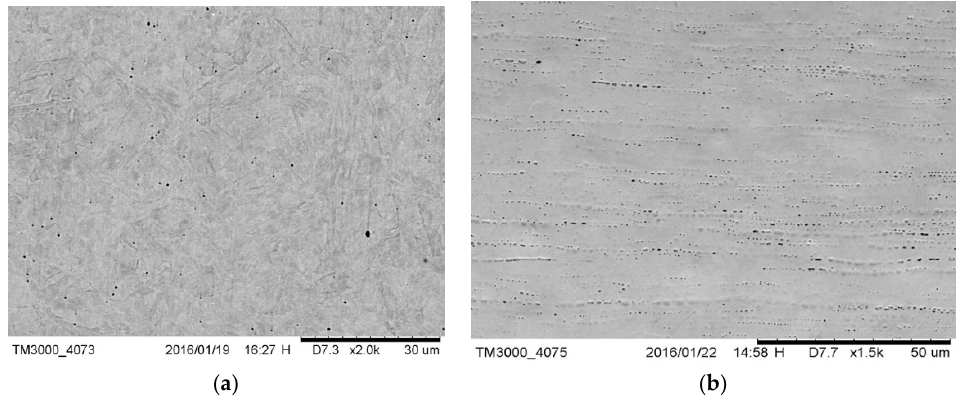
Figure 2. ( a ) Microstructure of drill E where sulfide precipitates were visible; ( b ) external surface of drill E; milling lines were visible.